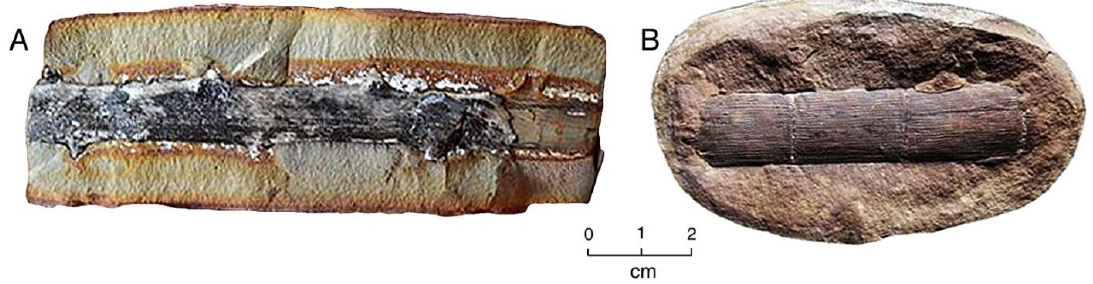
Figure 11. Sideritic “ironstone” nodules containing fossil wood, Pennsylvanian age, Mazon Creek, Braidwood, Illinois. ( A ) Unidentified woody twig; ( B ) Calamites .